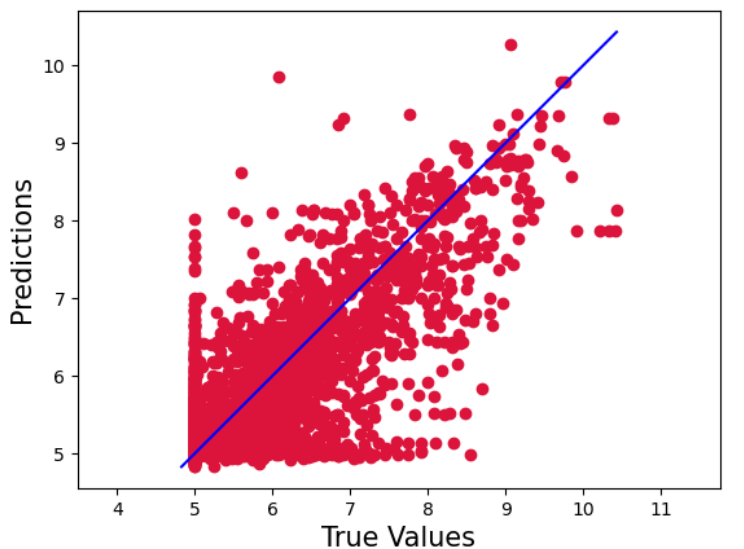
Figure 1. Predictions of the CSatDTA model vs. measured binding affinity values for the Davis dataset.